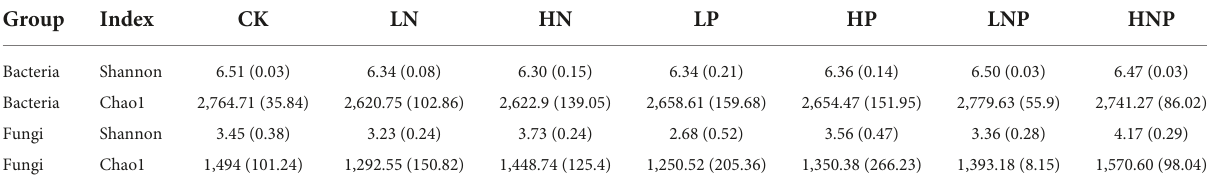
TABLE 1 Alpha diversity of bacteria (16S) and fungi (ITS) under different